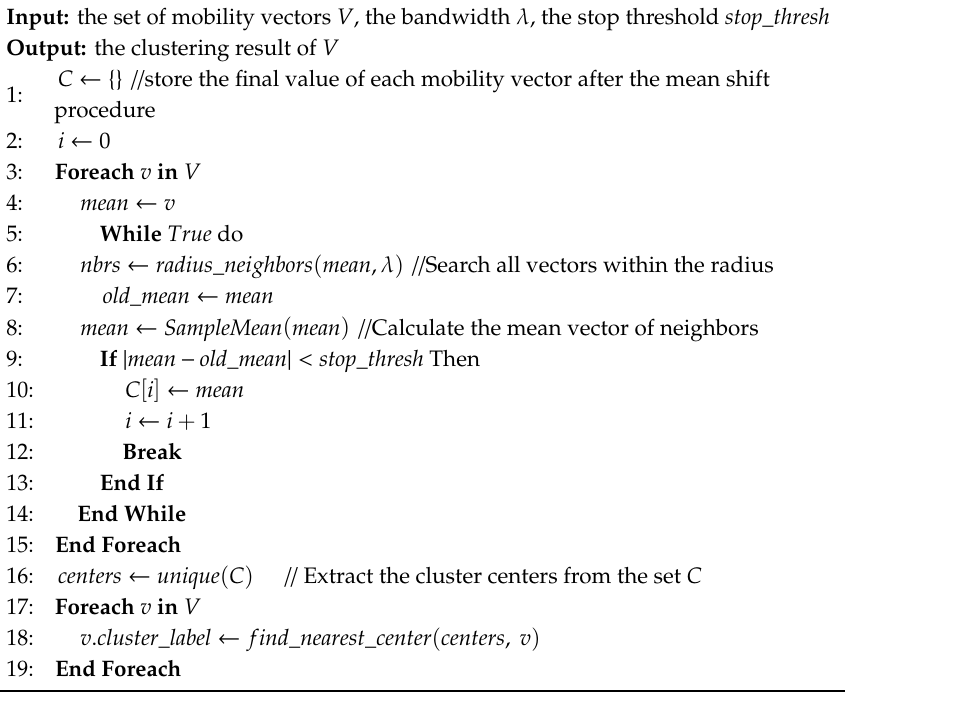
Algorithm 1: Mean shift clustering algorithm for mobility